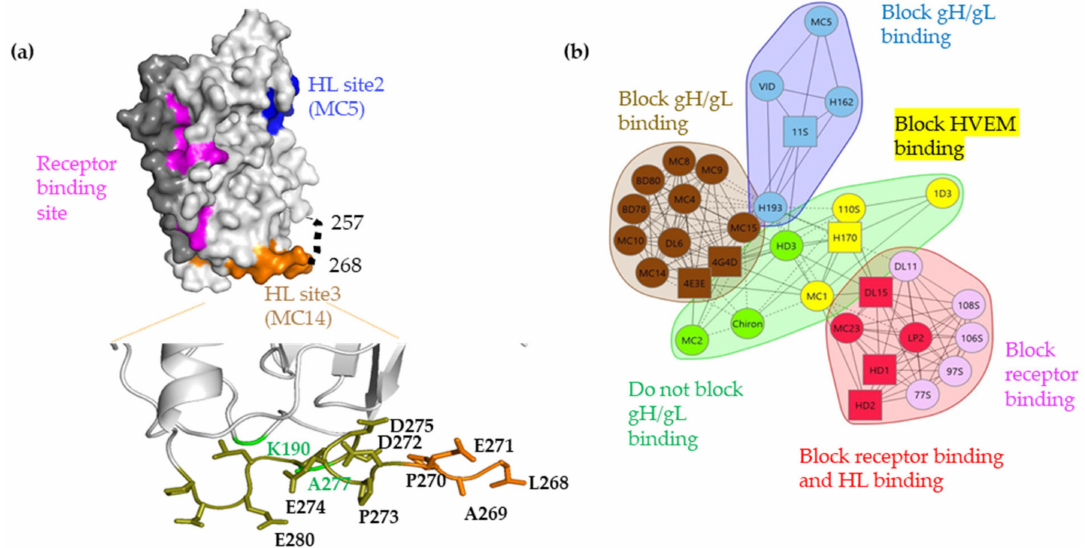
Figure 1. ( a ) Surface representation of gD306 crystal structure (PDB 2c36) showing the C-term (dark gray), the nectin-1 biding site (pink), and two of the three gH/gL binding sites defined by MC5 (site 2, blue) and MC14 (site 3, brown). gH/gL binding site 1 overlaps with the nectin-1 binding site. Region 257-267 which is missing from all crystal structures is shown as a dotted line and the C-term, lying over the receptor binding site. Point mutations generated in the gH/gL binding site 3 are shown as labelled side chains. In green are the point mutations that introduced the cysteine residues (at positions 190 and 277), which allow for the formation of a disulfide bond. ( b ) Based on competition and biological function, gD Mabs were grouped into communities: blue, brown, green, and red. The red community is subdivided into red and pink. The green community is subdivided into green and yellow. Circles indicate that competition was measured as both a ligand and an analyte; squares indicate that competition was measured as either a ligand or an analyte only. Solid connecting lines specify that competition between the two Mabs was measured in both directions (each as a ligand and analyte). Dashed connecting lines identify that the competition between Mabs was measured in one direction